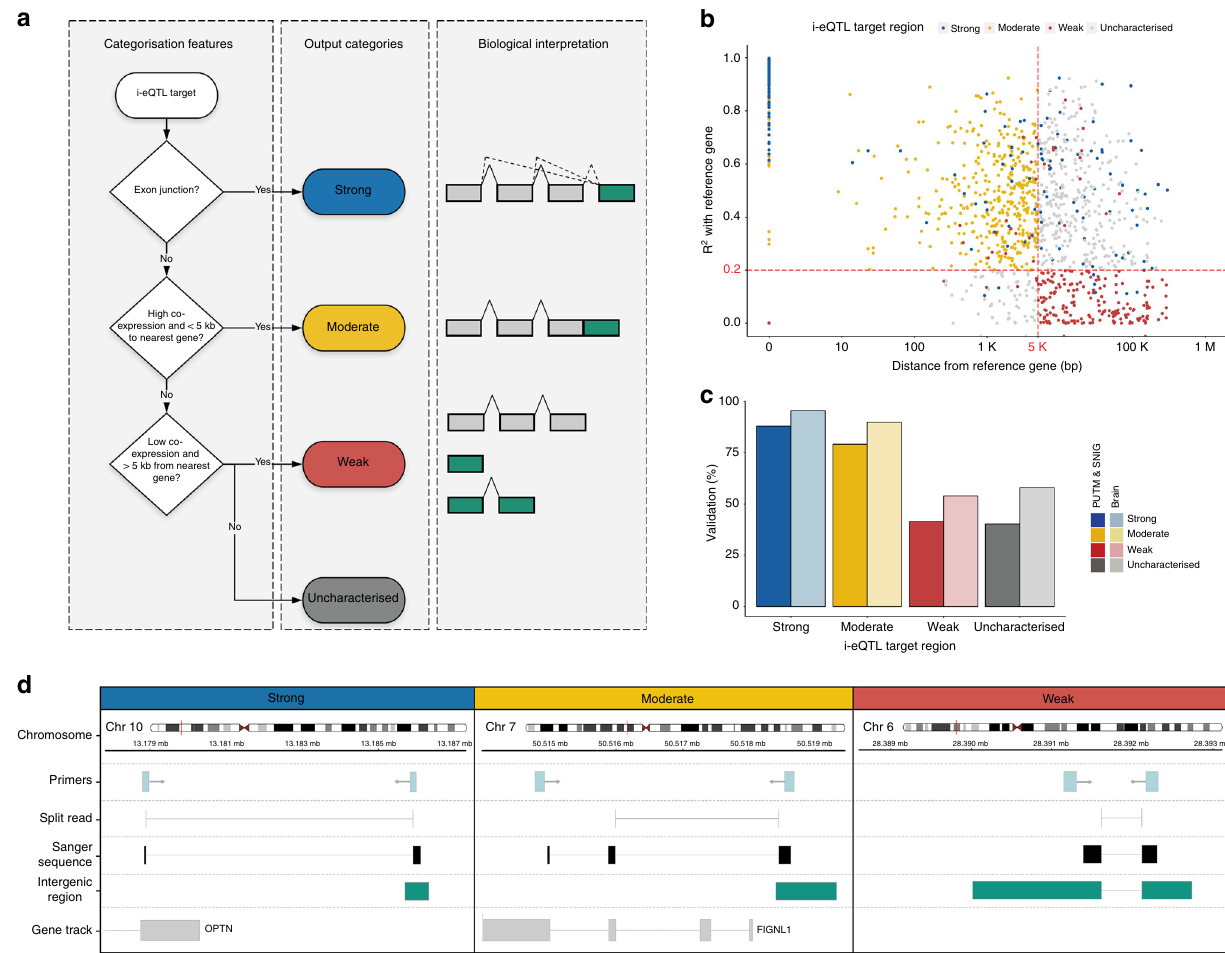
Fig. 2 i-eQTL target regions show high replication in independent data sets and validate experimentally. a Characterisation of i-eQTL target regions (unannotated expressed regions that were the target of a signi fi cant i-eQTL) was based on several features re fl ecting their relationship to known genes. These features were used to classify these regions into those with strong, moderate, and weak evidence for being part of a known gene. Regions categorised as strong and moderate are considered likely to be novel exons of known genes or misannotations of existing exon boundaries, whereas weak regions are presumed to be independent of any known genes. b Scatterplot of genomic distance and correlation of expression between i-eQTL target regions and their reference genes. c The expression of unannotated expressed regions was validated in GTEx data, using brain region-speci fi c and global brain expression data. Validation rates in putamen and substantia nigra GTEx expression data were combined and displayed separately from validation rates in RNA-seq data from all GTEx brain regions. d Sequencing results for i-eQTL target regions with strong, moderate, and weak evidence of being part of a gene. In each case, tracks are provided relating to the location of the primers used to amplify the unannotated expressed region, the RNA-seq split read, the alignment of Sanger-sequenced cDNA, and the predicted boundaries of the unannotated expression region. Source data are provided as a Source Data fi